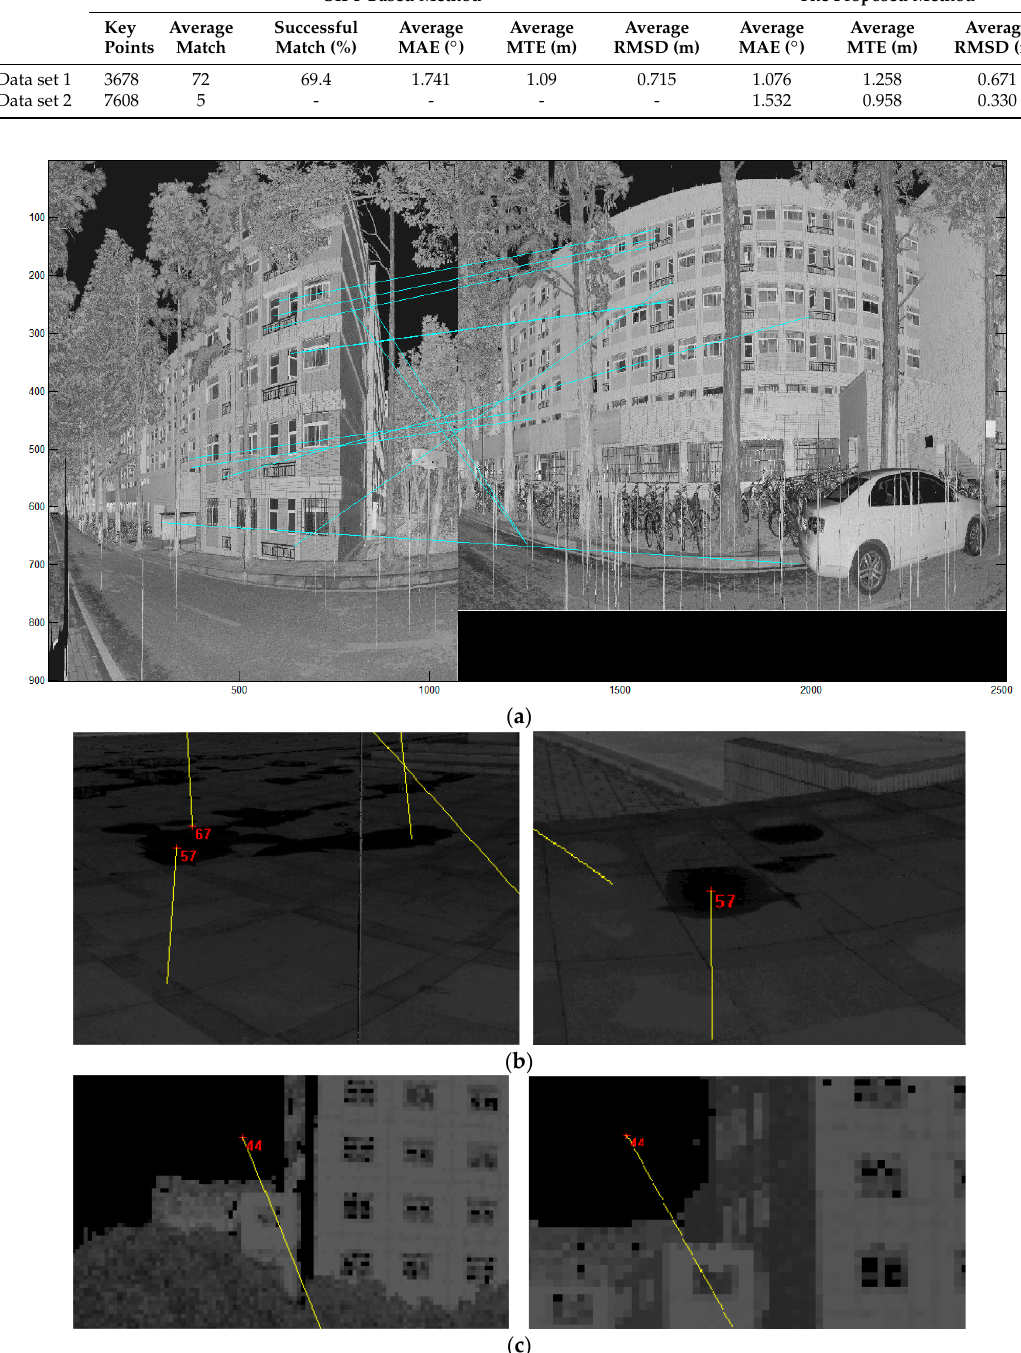
Figure 17. Matching results using SIFT: ( a ) the result of SIFT feature matching on S1–S2 in data set 2 and the false matching is mainly because of viewpoint changes and self-similarity; ( b ) the false match from holes; and ( c ) the correct match on the background with no correspondence in the space of point cloud.